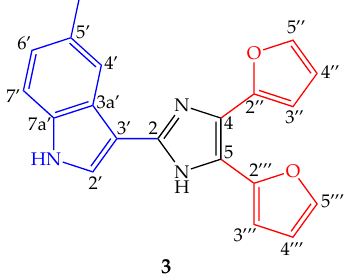
Figure 1. Structure of imidazole derivative 3 .